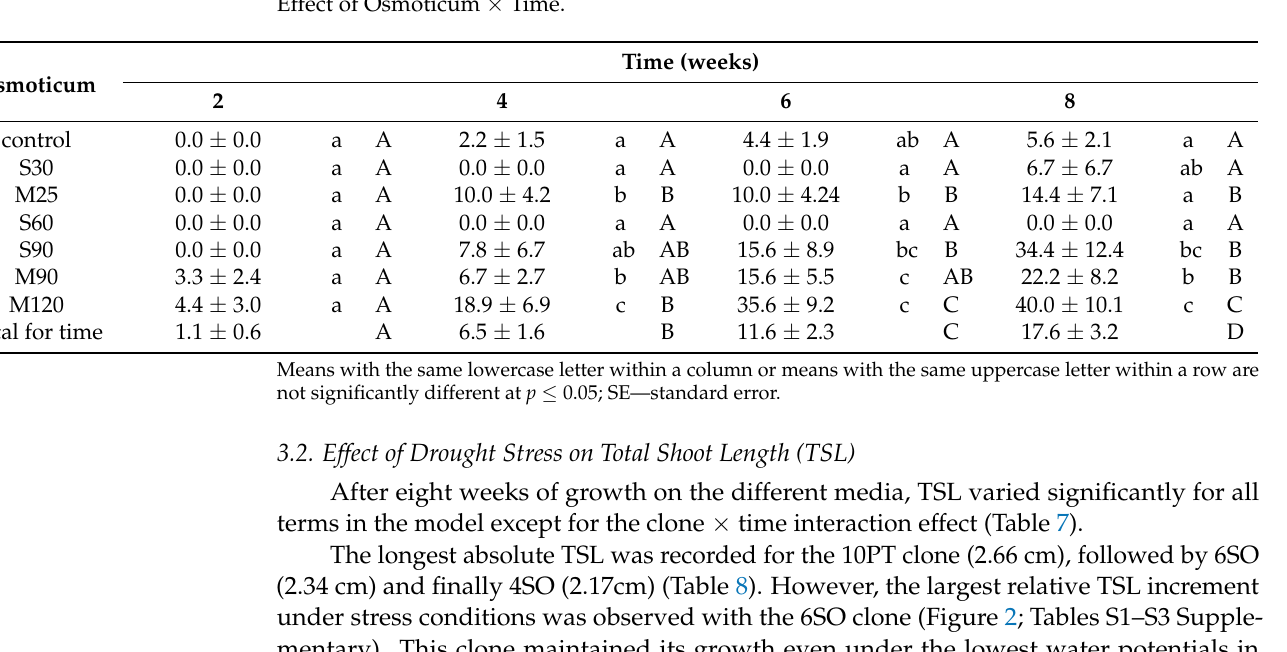
Figure 1. Effect of duration and magnitude of osmotic agents on mortality (%) of R. pseudoacacia clones (10PT, 4SO, 6SO) in in vitro culture conditions over 8-weeks of exposure to seven treatments. Different treatments are denoted as: “control”—medium without osmoticum, “S30”—medium with 30 gL − 1 of sucrose, “S60”—medium with 60 gL − 1 of sucrose, “S90”—medium with 90 gL − 1 of sucrose, “M25”—medium with 25 gL − 1 of mannitol, “M90” medium with 90 gL − 1 of mannitol, “M120” medium with 120 gL − 1 of mannitol. Table 6. Mean ± SE mortality rate M (%) of R. pseudoacacia clones (10PT, 4SO, 6SO) for different treatments measured after 2, 4, 6, and 8 weeks of drought stress exposure. Different treatments are denoted by the water potential ( Ψ ) and the osmotic agent and its concentration in the medium. “control”—medium without osmoticum, “S30”—medium with 30 gL − 1 of sucrose, “S60”—medium with 60 gL − 1 of sucrose, “S90”—medium with 90 gL − 1 of sucrose, “M25”—medium with 25 gL − 1 of mannitol, “M90” medium with 90 gL − 1 of mannitol, “M120” medium with 120 gL − 1 of mannitol. Effect of Osmoticum × Time.